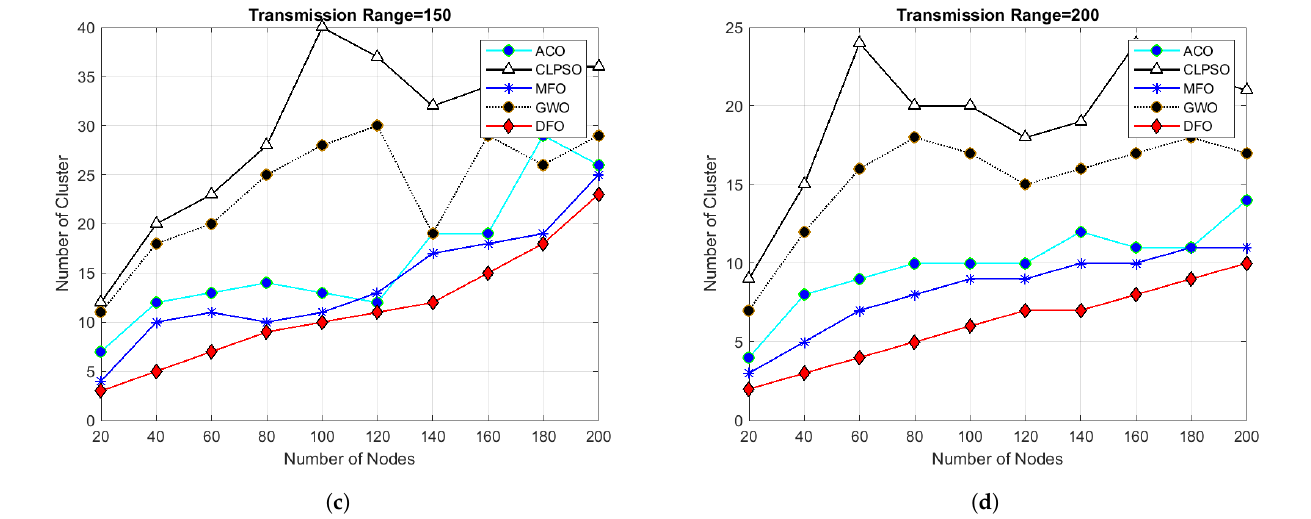
Figure 6. Grid size 1500 m × 1500 m and number of nodes 20 to 200.